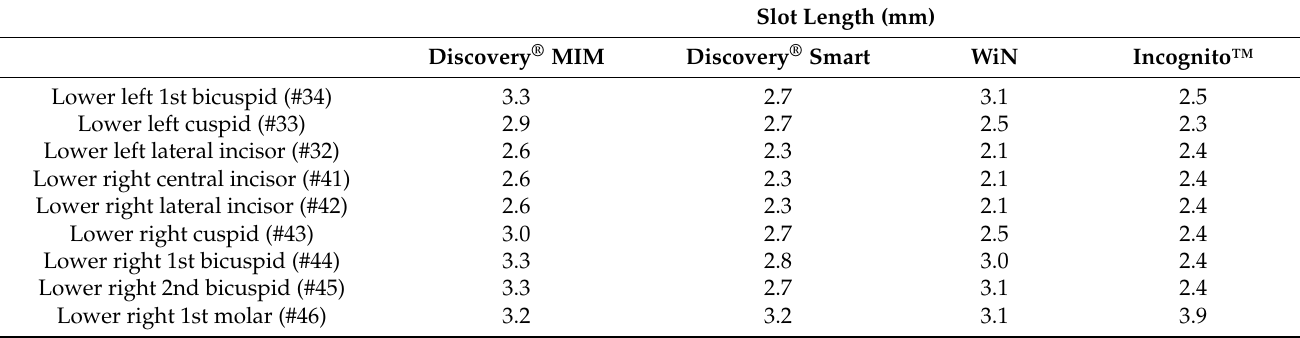
Table 2. Slot lengths (according to ISO27020:2019) and distance between the adjacent slots of all the appliances used in this study.